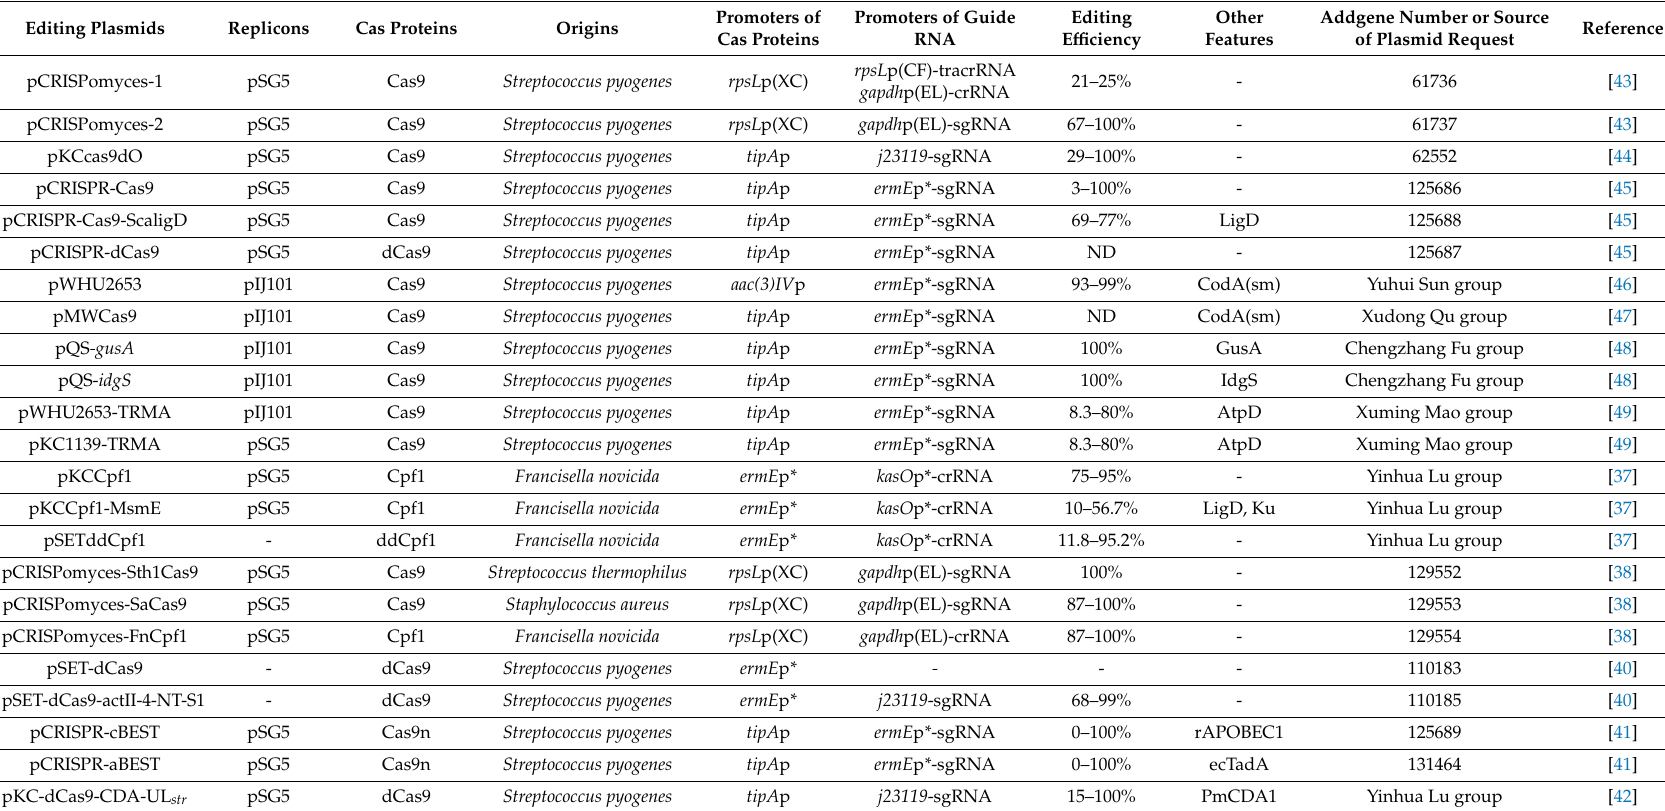
Table 1. The clustered regularly interspaced palindrome repeat (CRISPR) / CRISPR-associated protein (Cas) system–based plasmids developed for genome editing in